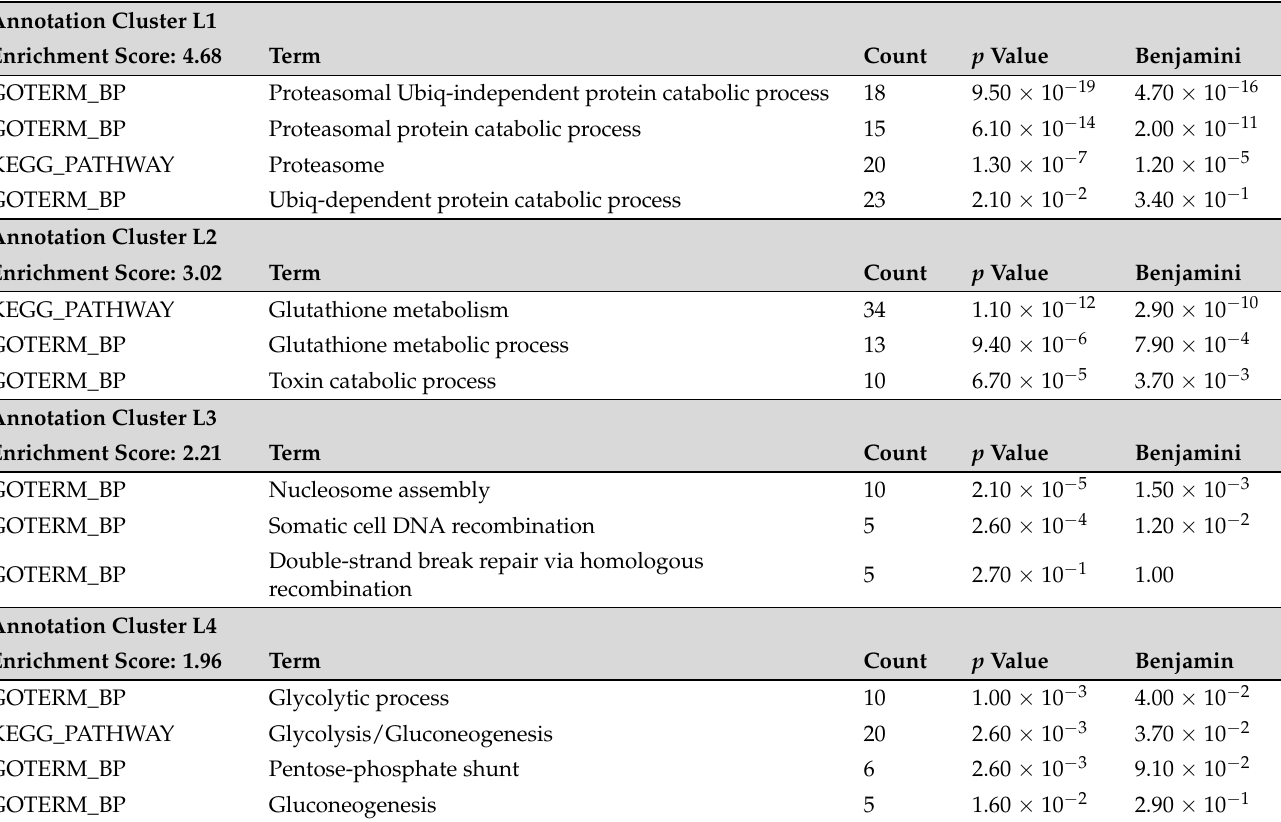
Table 2. Functional Annotation Clustering by GO_Biological Function and KEGG pathway of the proteins only present or more persulfidated in light collected sample